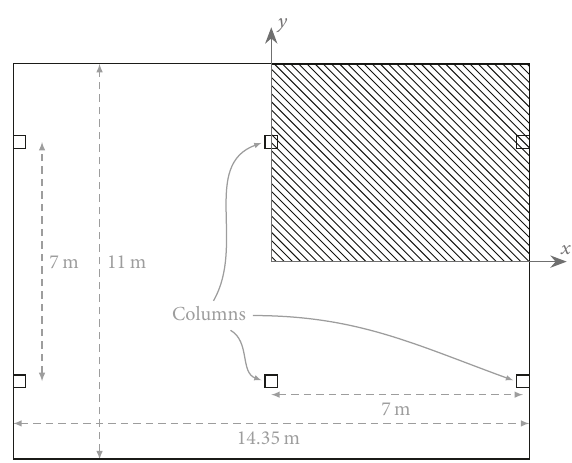
Figure 2: Plan view of test structure, which is symmetric with respect to 𝑥 and 𝑦 axes. The reinforcement of the shadowed quarter is defined in Table